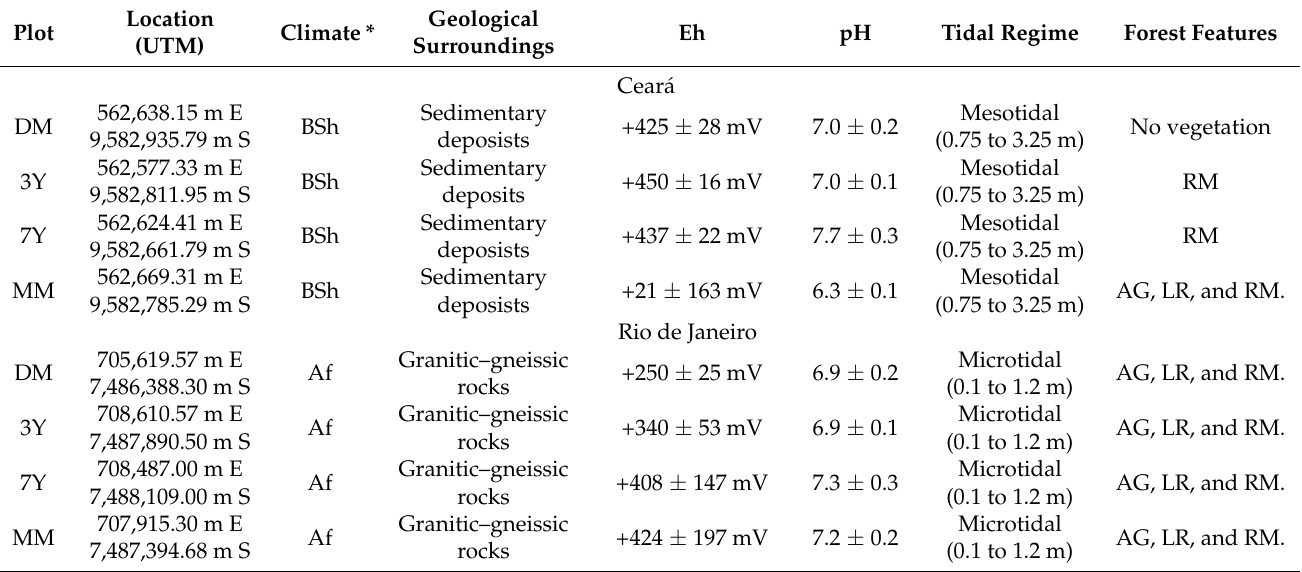
Table 1. Location, geoclimatic and physicochemical (pH and Eh) characteristics, tidal regime, and forest structure of studied mangrove forests from each